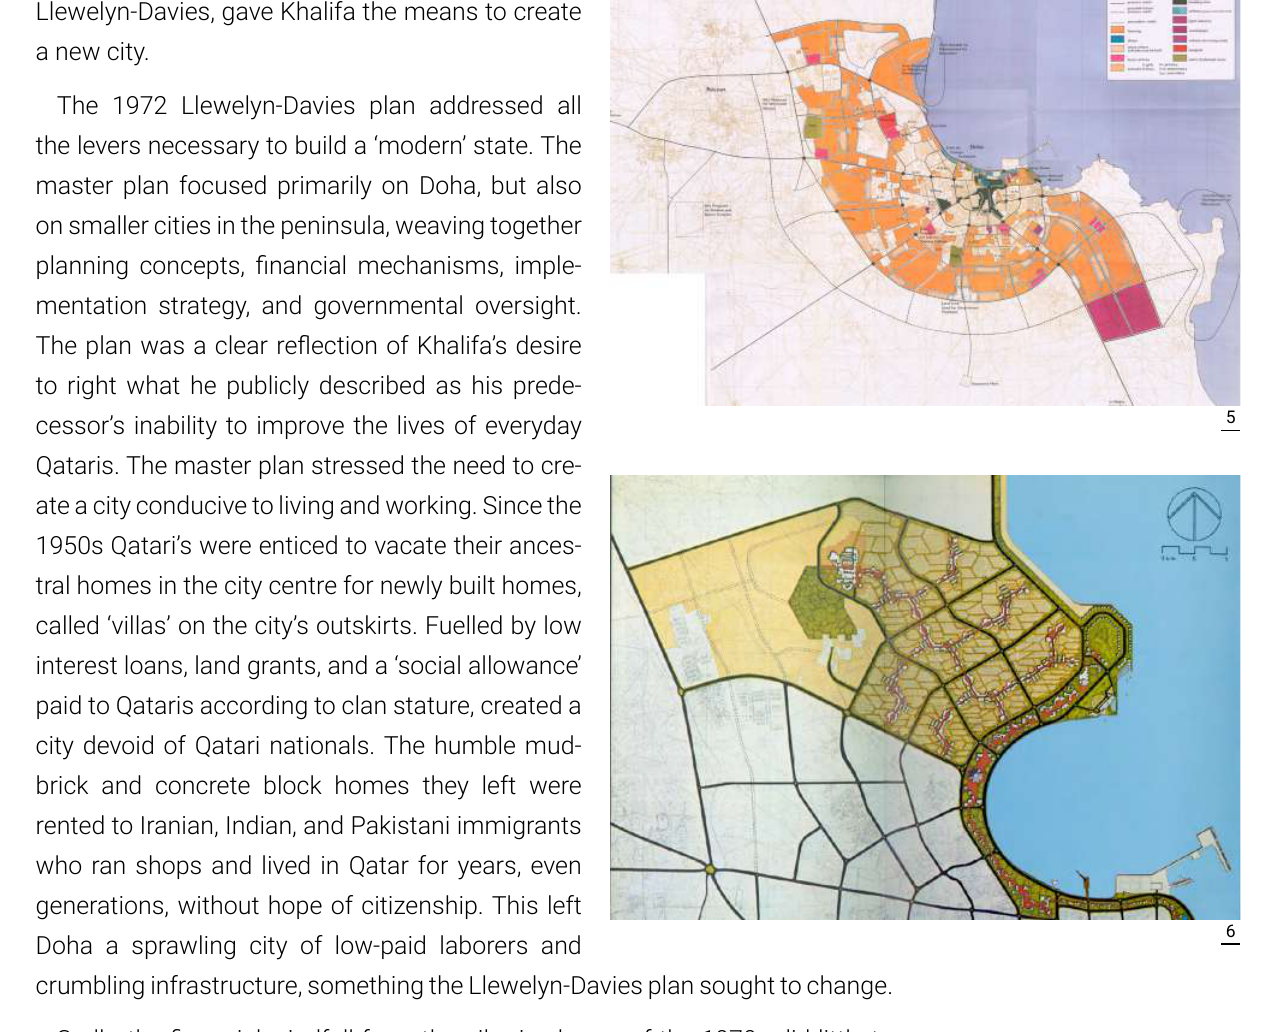
1975 William L. Pereira West Bay master plan (Source: Wil - liam L. Pereira